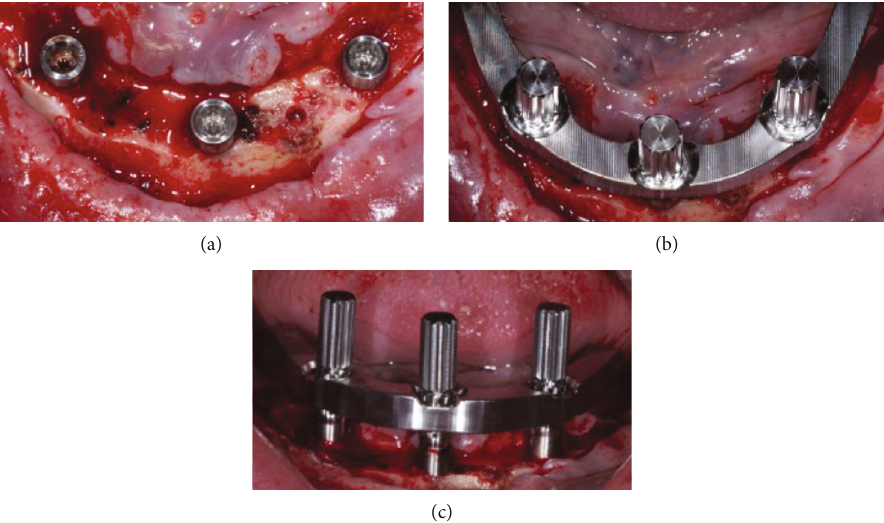
Figure 5: All the implants are placed (a), and the prefabricated titanium bar is screwed on the fi xtures (b, c).